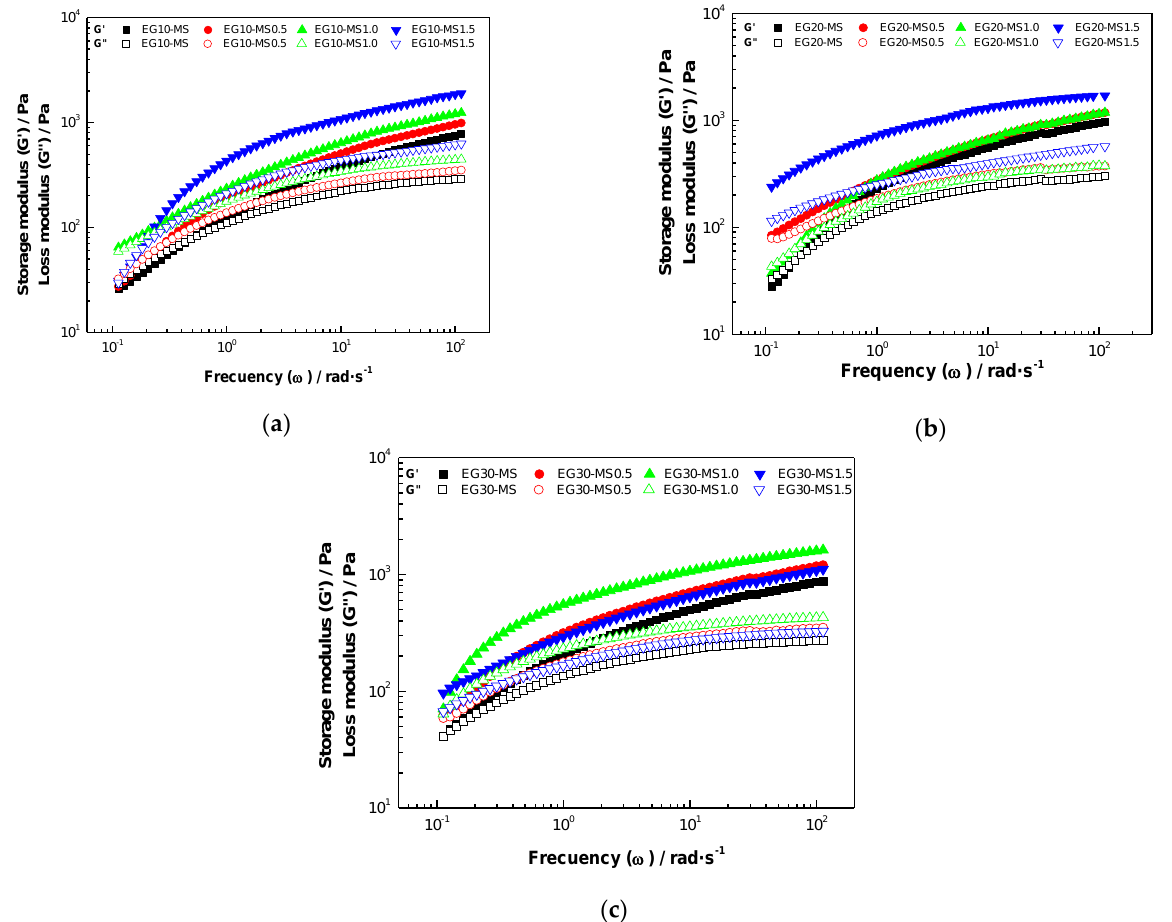
Figure 3. The storage modulus ( 𝐺 ′ ) and modulus ( 𝐺 ′′ ) as a function of frequency ( ω ) of carboxymethyl cellulose/mango- starch emulsion gels with 1% w/w of mango peel extracts at ( a ) 10%, ( b ) 20% and ( c ) 30% of canola oil (cv < 0.05%)